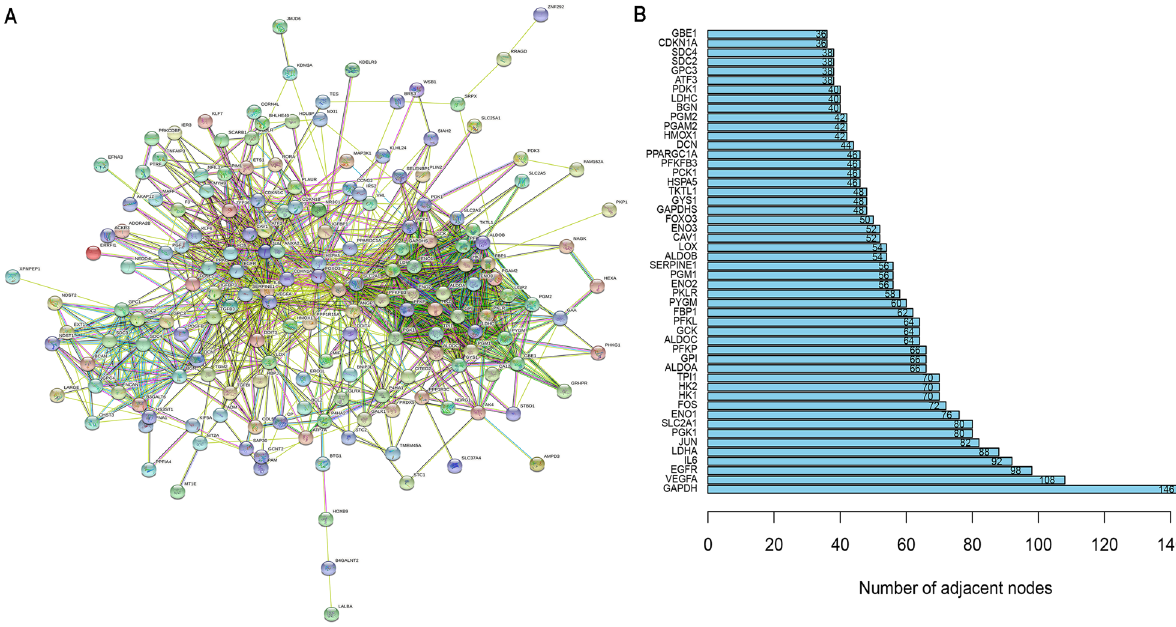
Figure 1. Screening hypoxia genes. ( A ) The protein interaction network diagram of hypoxia gene. ( B ) Histogram of the top fifty hypoxia